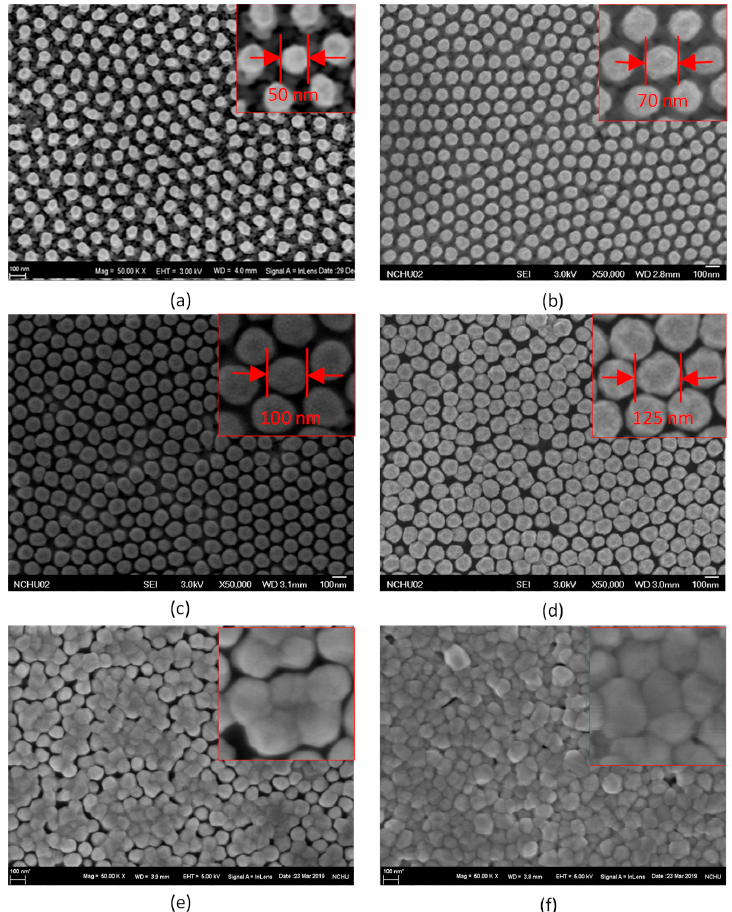
Figure 3. The SEM images show silver nanospheres uniformly distributed on the nanocone array substrate. ( a – f ) show different sputtering duration of 50, 100, 150, 200, 250 and 300 s, respectively. Top right corner of each image shows the silver nanospheres at higher magnification for easier to observe their morphology. It can be seen that the longer the duration, the larger the diameter of these nanospheres. If the sputtering duration is too long, the nanospheres will start to merge. By carefully adjusting the sputtering duration, we can fine-tune the diameter of the nanosphere so that we can control the gaps between the nanospheres in the range of a few nanometers.